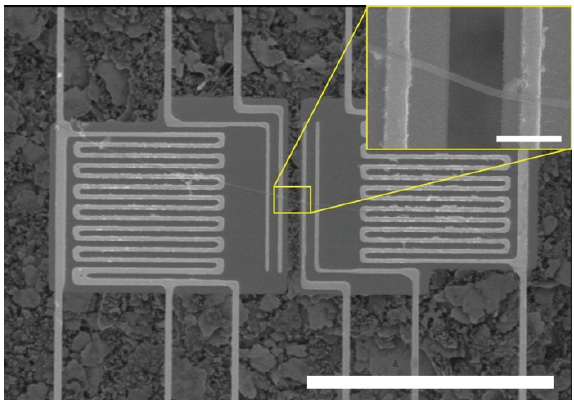
Figure 1. SEM images of an electrospun PAA NF assembled on a suspended microdevice. The inset shows an enlarged view of the PAA NF, which bridges between two membranes. The scale bars are 50 μ m and 2 μ m, respectively.